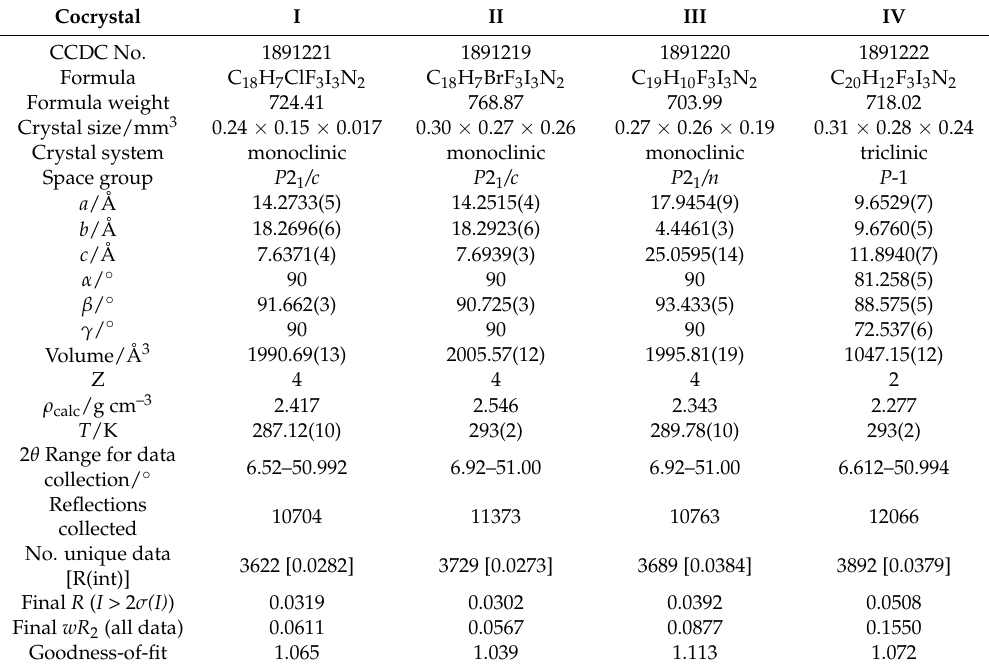
Table 1. Crystallographic data and structure refinement parameters for I , II , III and IV .